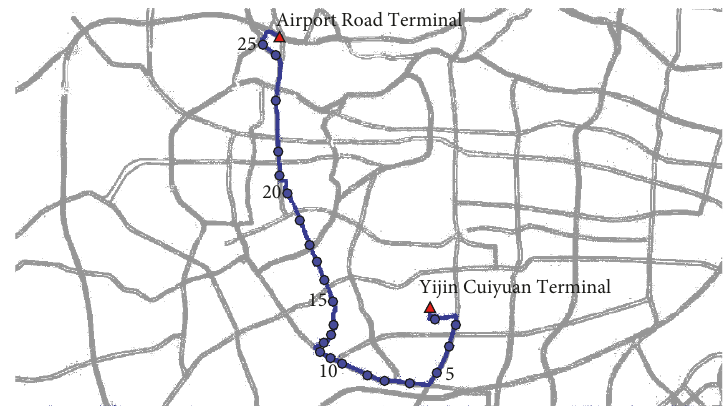
Figure 2: Bus route 87. The direction of the bus route discussed in this article is from the bottom to the up.